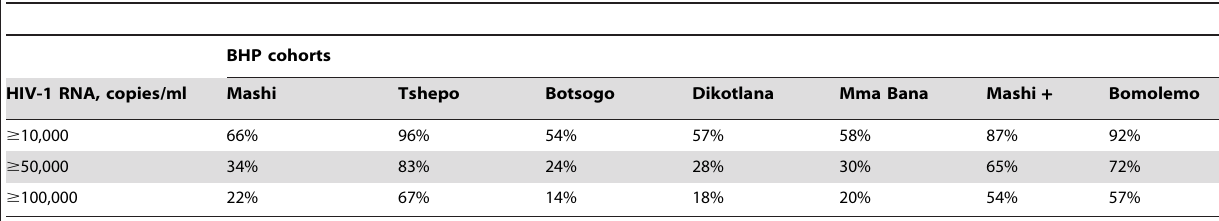
BHP cohorts HIV-1 RNA, copies/ml Mashi Tshepo Botsogo